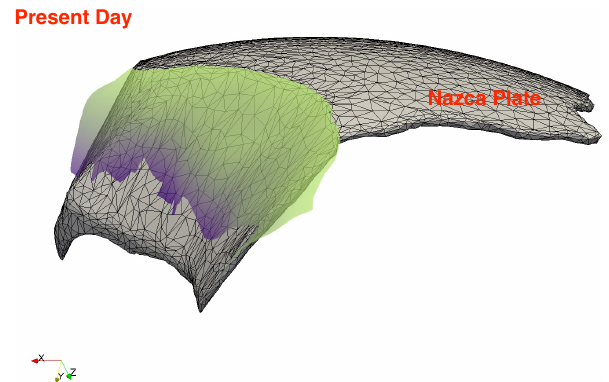
Figure A2. North side view of the Nazca plate at present day for geodynamic model input. The green to purple coloured topology represents the depth of the Nazca slab from the Slab1.0 ( Hayes et al., 2012) interpretation. The black mesh over the plate indi- cates the resolution of the model. The Slab1.0 interpretation is made slightly transparent to see the extent of modelled plate.